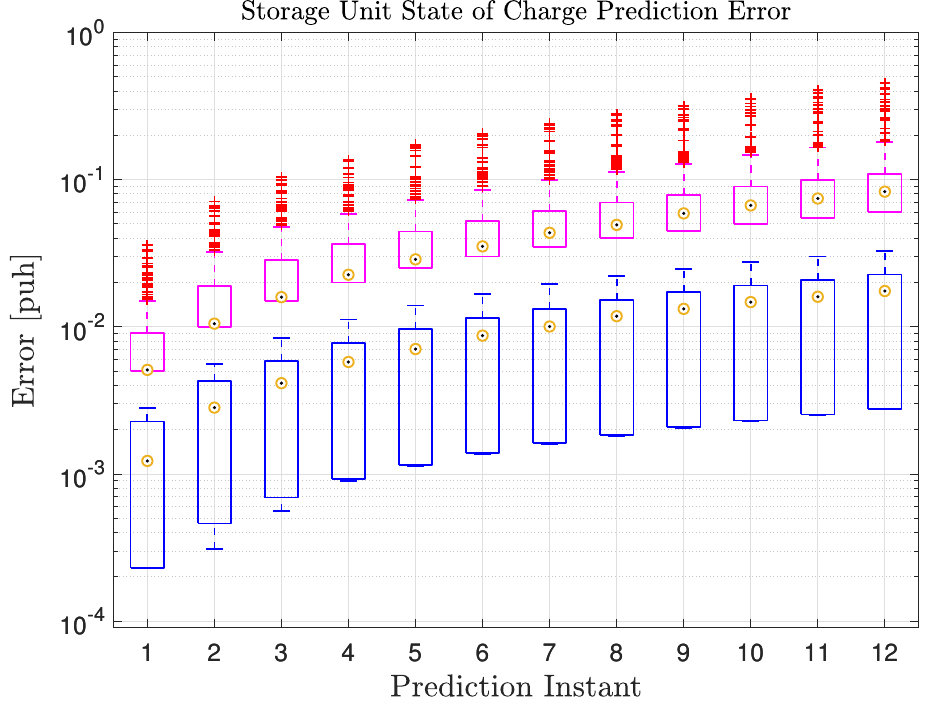
Figure 4. The prediction error of the state of charge (Up) with the dynamic storage without piecewise affine loss model (26)–(29d) in the controller; (Down) with the dynamic storage with piecewise affine loss model (10)–(25) in the